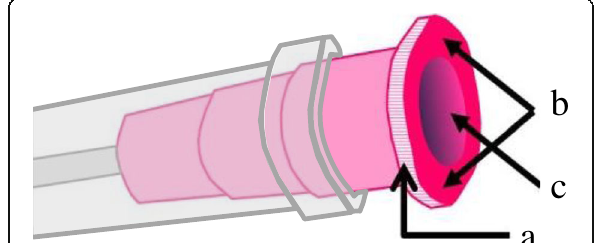
Fig. 2 Contamination was evaluated in each region of the needle hub. a Lateral surface. b Bottom surface. c Inner